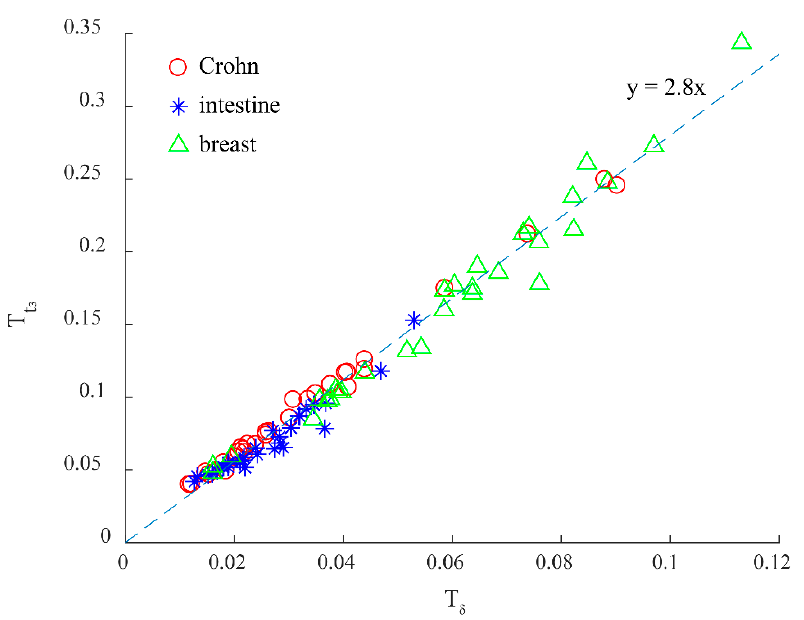
Figure 8. Comparison between T δ : T values of the MMPD parameter δ , and T t 3 : T values of the MMT parameter t 3 for 90 human pathological tissue slices. X-axis: T δ . Y-axis: T t 3 . Red circles: Crohn-Crohn disease tissues. Blue asterisks: intestine-intestinal tuberculosis tissues. Green triangles: breast-breast carcinoma tissues.